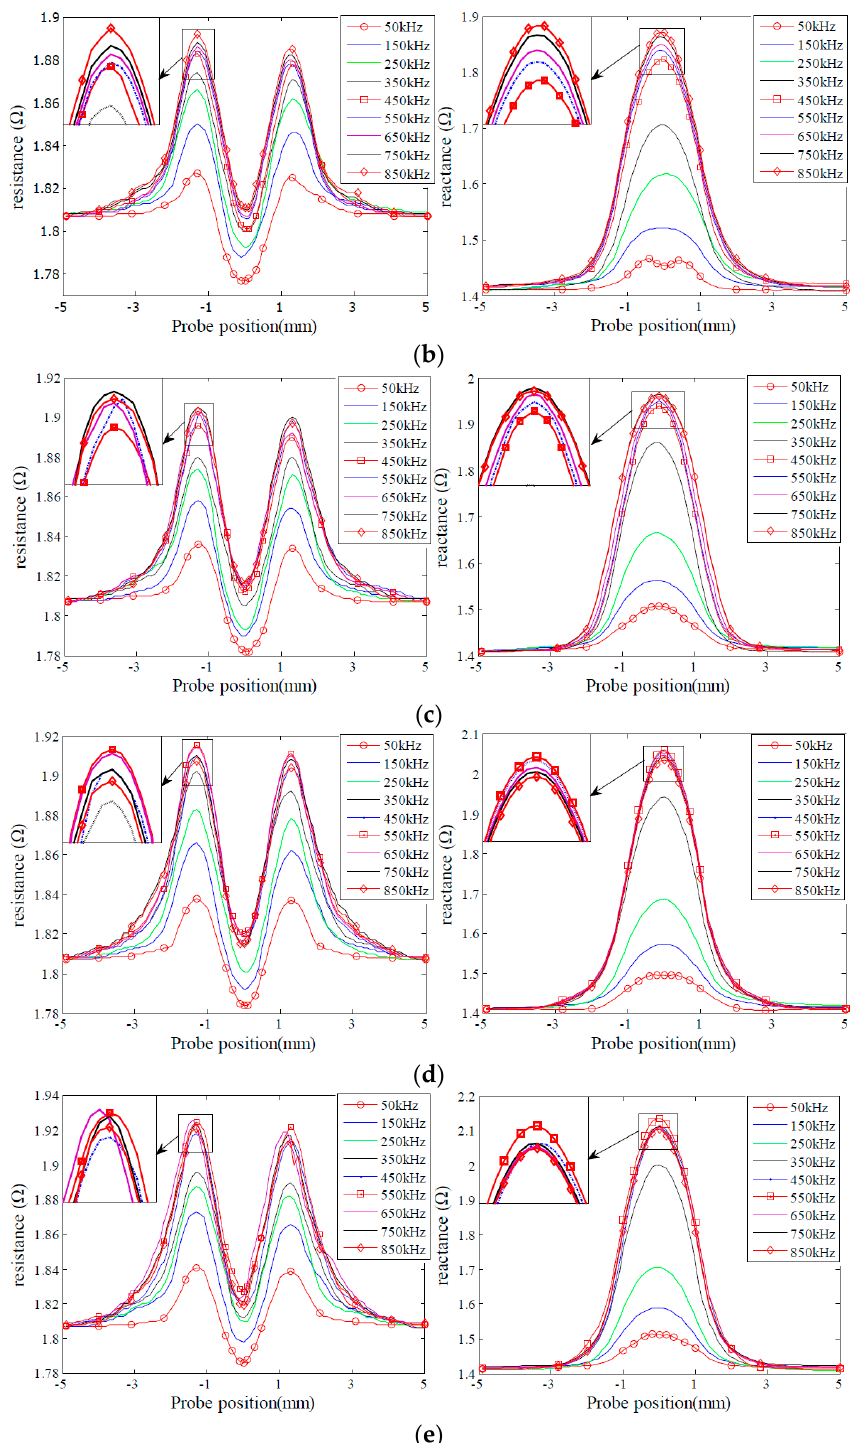
Figure 4. Probe signals due to the defects with different lengths: ( a ) Probe signals due to the defect L1; ( b ) probe signals due to the defect L2; ( c ) Probe signals due to the defect L3; ( d ) Probe signals due to the defect L4; ( e ) Probe signals due to the defect L5.